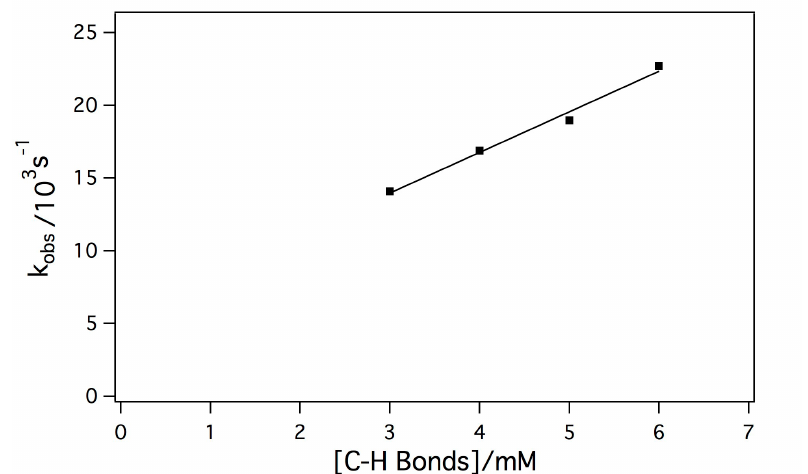
Figure 5. Plot of k obs against substrate concentration in order to determine the second-order rate constant of the reaction between the Mn-myoglobin intermediate with 1,4 cyclohexadiene ( k = 2.79 +/− 0.22 M −1 s −1